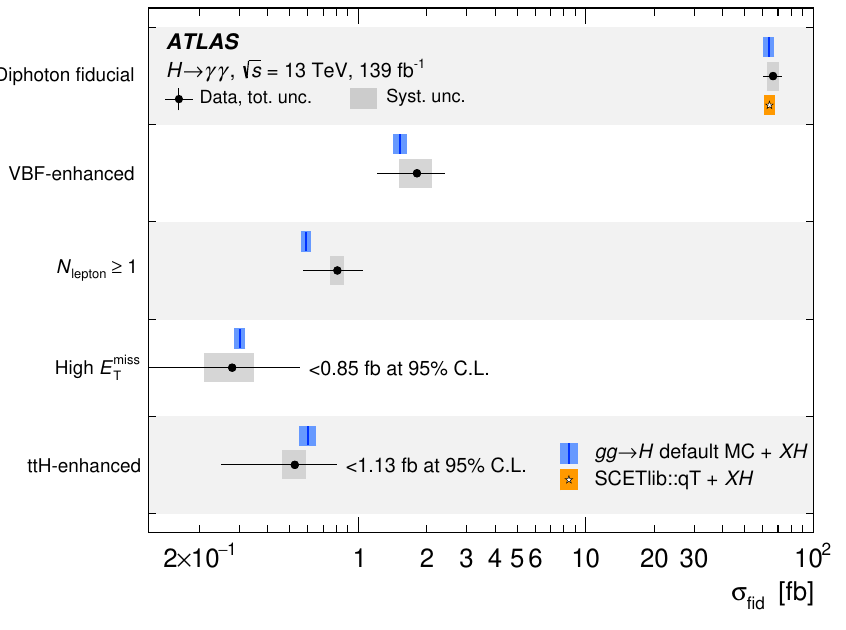
Figure 6. Particle-level cross-sections times branching ratio in the five fiducial regions. The data are shown as filled (black) circles. The error bar on each measured cross-section represents the total uncertainty in the measurement, with the systematic uncertainty shown as a dark grey rectangle. The default prediction with its uncertainty is superimposed. XH indicates all the Higgs production modes except for ggF. Upper limits at 95% CL are shown for fiducial regions with observed significance below 3 σ